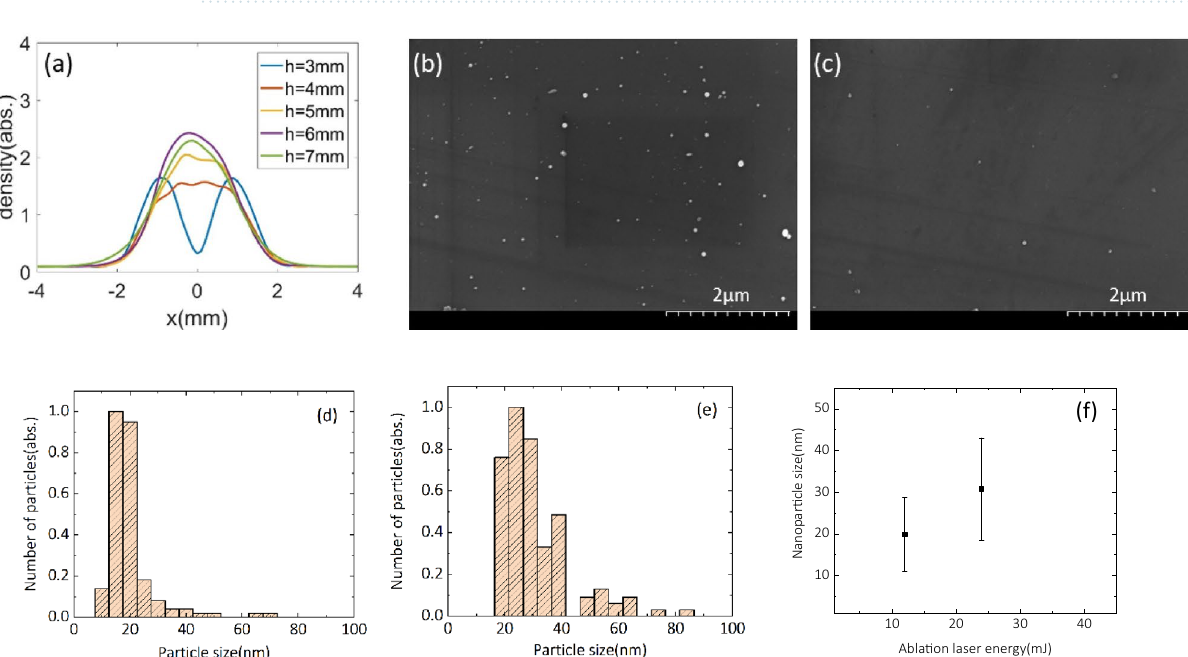
Figure 5. ( a ) Gas density profile at different heights above the nozzle exit calculated from the CFD simulation. ( b ) SEM data of a nanoparticle-deposited silicon wafer surface shows the nanoparticle density reaches maximum at x = 0. ( c ) SEM image was taken at x = 25 μm. Nanoparticles size distribution with the ablation laser fluence of ( d ) 84 J/cm 2 and ( e ) 180 J/cm 2 . ( f ) The average sizes and deviations of the nanoparticles with the ablation laser